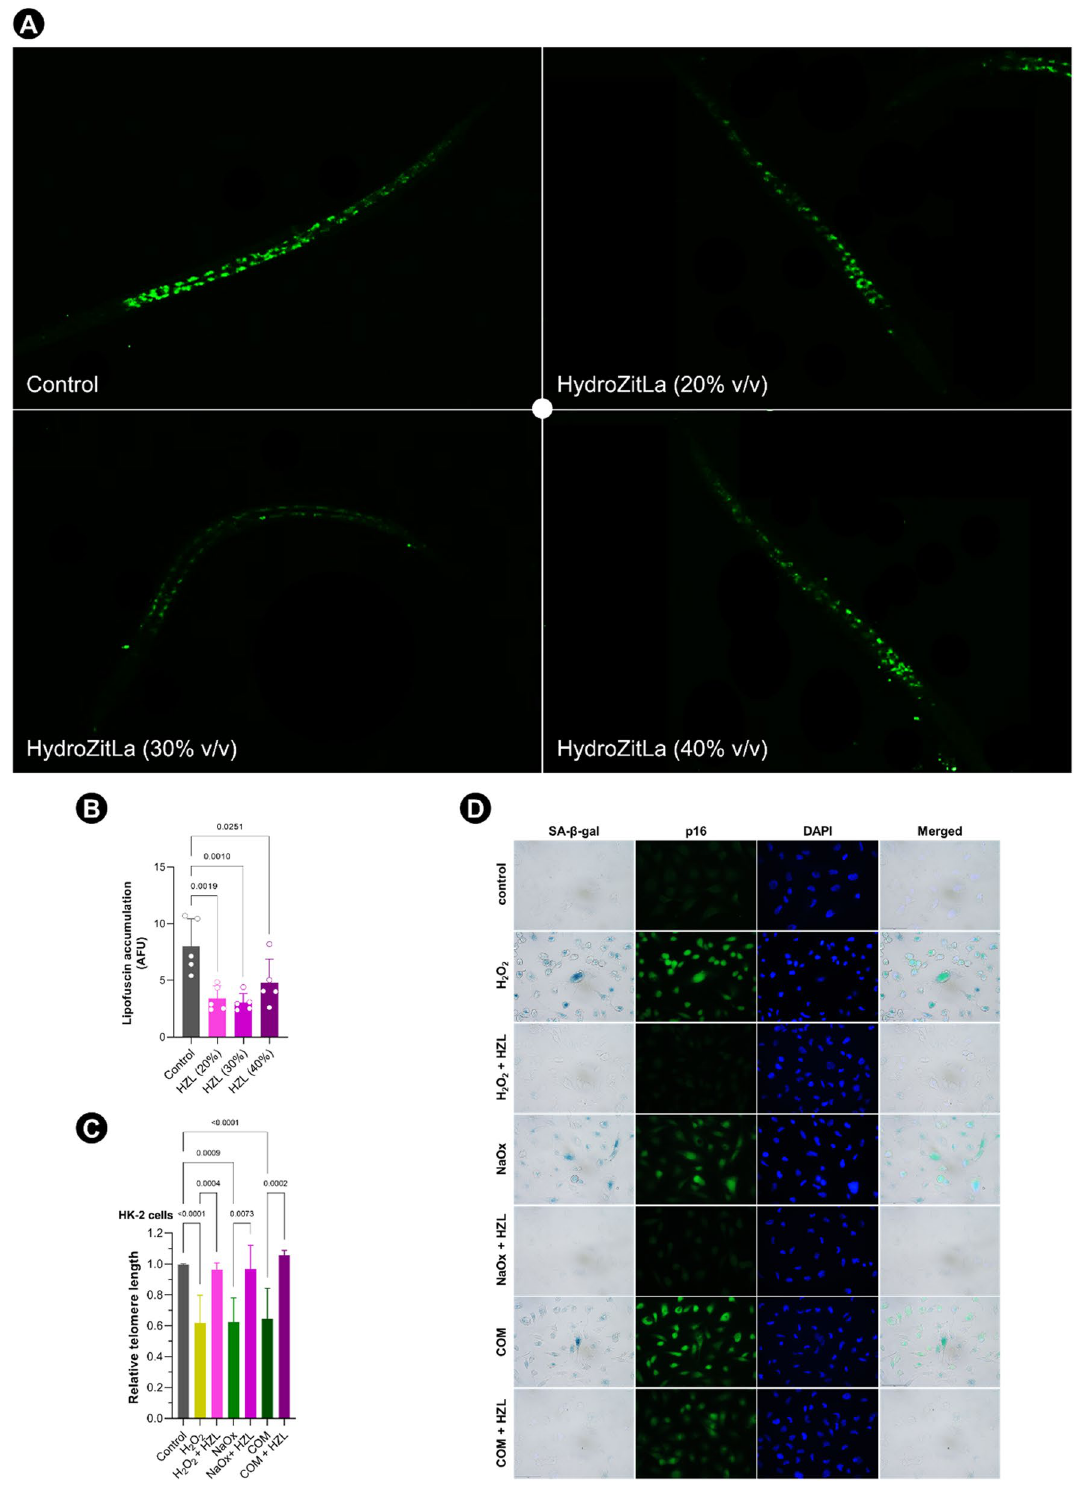
Figure 6. Anti-aging effect of HydroZitLa (HZL) tested in C. elegans and HK-2 cells. ( A ) HydroZitLa supplementations at 20%, 30%, and 40% v/v clearly decreased lipofuscin accumulation in C. elegans . ( B ) Autofluorescent intensities of lipofuscin in HydroZitLa- supplemented nematodes (for all tested concentrations) were significantly lower than that in non-supplemented control. ( C ) Relative telomere lengths in HK-2 cells treated with H 2 O 2 , sodium oxalate (NaOx), and calcium oxalate monohydrate (COM) were significantly lower than untreated control. HydroZitLa co-treatment significantly inhibited shortening of telomere in HK-2 cells treated with H 2 O 2 , NaOx, and COM. ( D ) Double staining of SA-β-gal and p16 demonstrated that H 2 O 2 , NaOx, and COM induced premature senescence (as indicated by increased proportion of SA-β-gal positive cells) and upregulation of p16 expression. p16 was strongly upregulated in those SA-β-gal positive cells. HydroZitLa co-treatment effectively inhibited upregulation of p16 and onset of premature senescence in HK-2 cells exposed to lithogenic stressors. Magnifications: × 100 ( A ), × 400 ( D